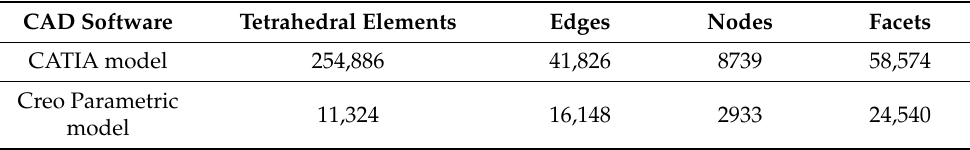
Table 1. Data referring to the mesh size.